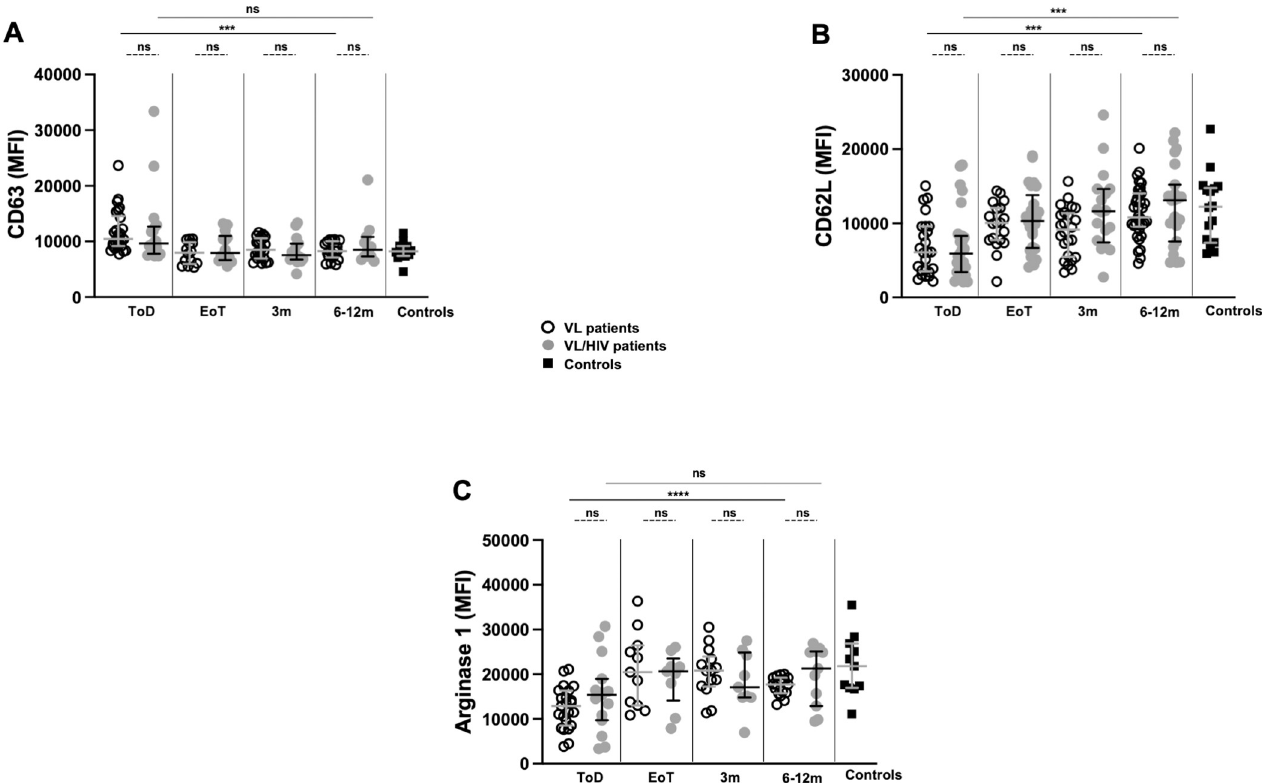
Fig 2. Comparison of neutrophil CD63, CD62L and arginase 1 expression levels between VL and VL/HIV patients and controls over time. Neutrophils were isolated from whole blood by dextran sedimentation as described ibn Materials and Methods: A. The expression levels (MFI = Median Fluorescence Intensity) of CD63 expression levels were measured on neutrophils from controls (n = 12), VL (ToD: n = 26, EoT: n = 14 3m: n = 22, 6-12m: n = 18) and VL/ HIV (ToD: n = 18, EoT: n = 14, 3m: n = 15, 6-12m: n = 11) patients by flow cytometry as described in Materials and Methods. B. The expression levels (MFI) of CD62L expression levels were measured on neutrophils from controls (n = 18), VL (ToD: n = 25, EoT: n = 19 3m: n = 24, 6-12m: n = 34) and VL/HIV (ToD: n = 27, EoT: n = 25, 3m: n = 18, 6-12m: n = 23) patients by flow cytometry as described in Materials and Methods; C. The intracellular expression levels (MFI) of Arginase 1 levels were measured in neutrophils from controls (n = 11), VL (ToD: n = 23, EoT: n = 11, 3m: n = 14, 6-12m: n = 17) and VL/HIV (ToD: n = 15, EoT: n = 9, 3m: n = 9, 6-12m: n = 11) patients by flow cytometry as described in Materials and Methods. Each symbol represents the value for one individual. Results are presented as median with interquartile range. Statistical differences between VL and VL/HIV patients at each time point were determined using a Mann-Whitney test and statistical differences between the 4 different time points for each cohort of patients were determined by Kruskal-Wallis test. ToD = Time of Diagnosis; EoT = End of Treatment; 3m = 3 months post EoT; 6-12m = 6–12 months post EoT. ns = not